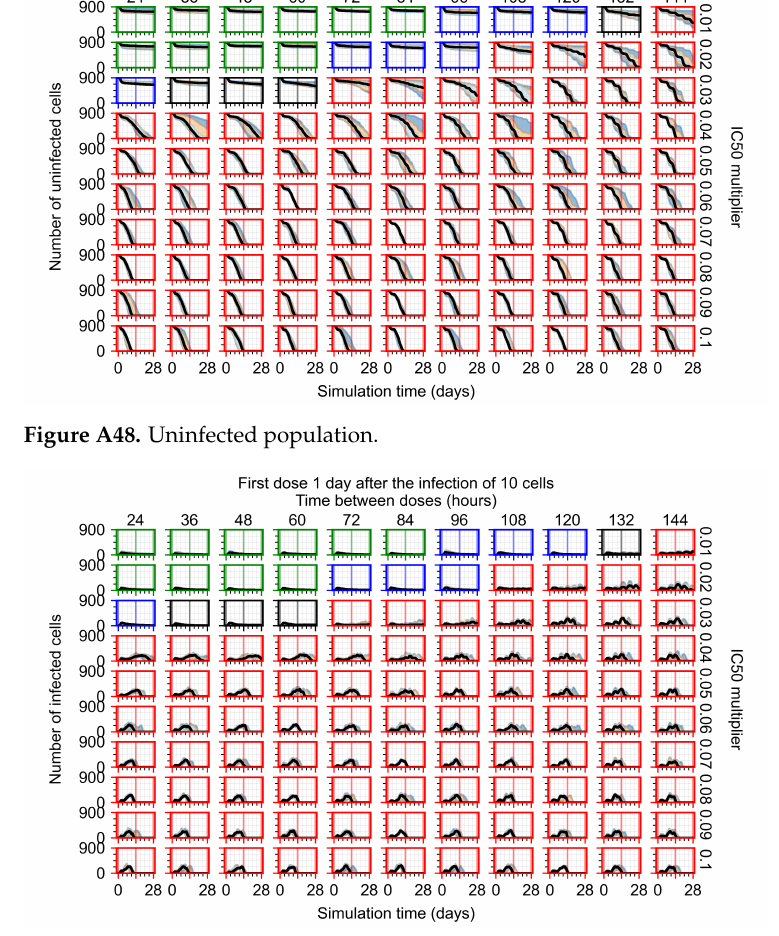
Figure A49. Infected (eclipse phase)